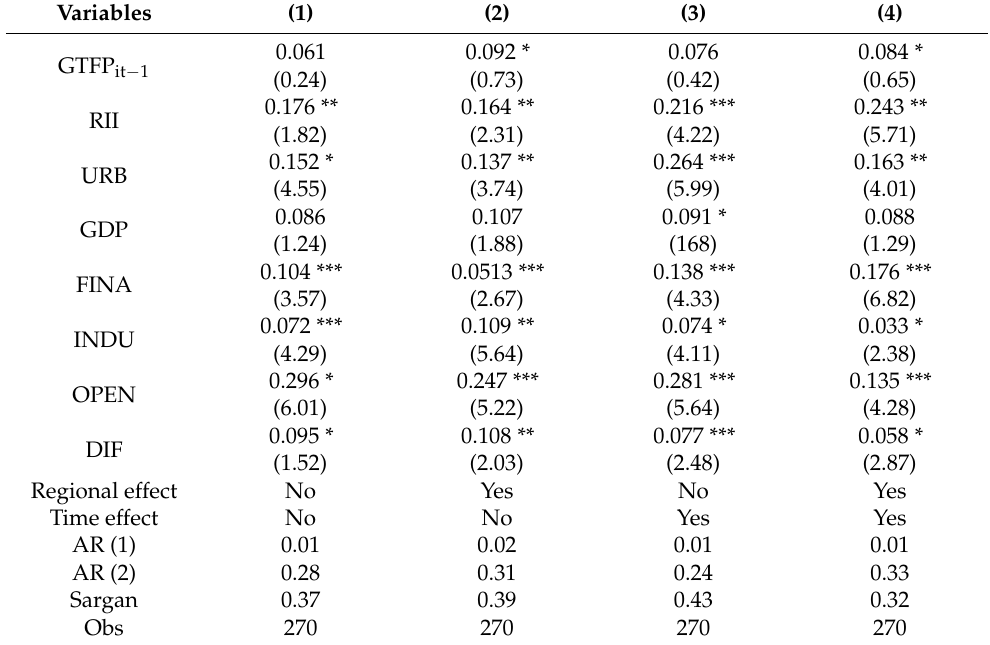
Table 4. Baseline regression